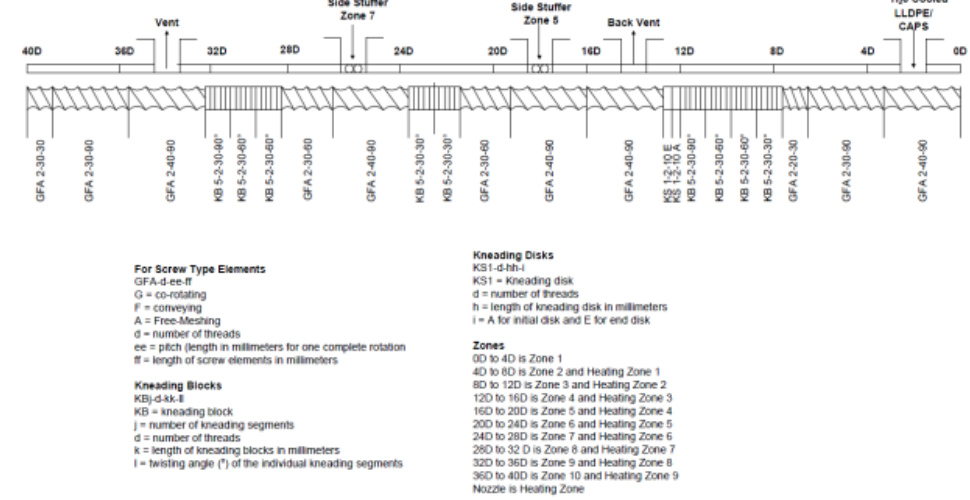
Figure 3. Extruder screw design.